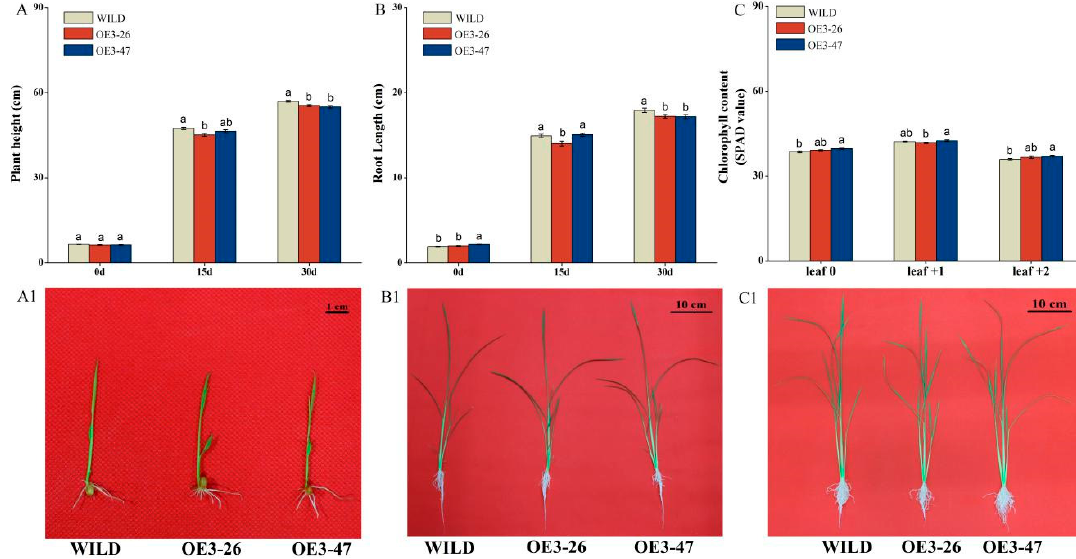
Figure 3. Growth attributes of OsMKK3- overexpressing lines (OE3-26,47) and wild-type plants (WILD). ( A , B ) Plant height and root length (mean ± SE, n = 30) of oe-MKK3 and WILD at day 0, day 15, and day 30 after transplanting to hydroponic boxes; ( A1 , B1 , C1 ) Growth phenotypes of oe-MKK3 and WILD at day 0, day 15, and day 30 after transplanting to hydroponic boxes; ( C ) Chlorophyll content (mean ± SE, n = 30) of oe-MKK3 and WILD at day 30 after transplanting to hydroponic boxes; leaf 0 refers to the newest growth leaf; leaf +1 refers to the leaf which wraps leaf 0; leaf +2 refers to the leaf which wraps leaf +1. Different letters mean significant differences among oe-MKK3 and wild-type plants (Duncan’s multiple range test, p < 0.05).